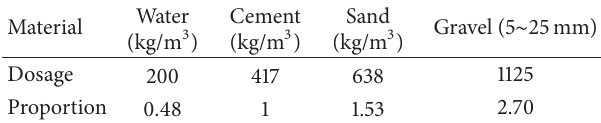
Table 2: Concrete mix proportion.